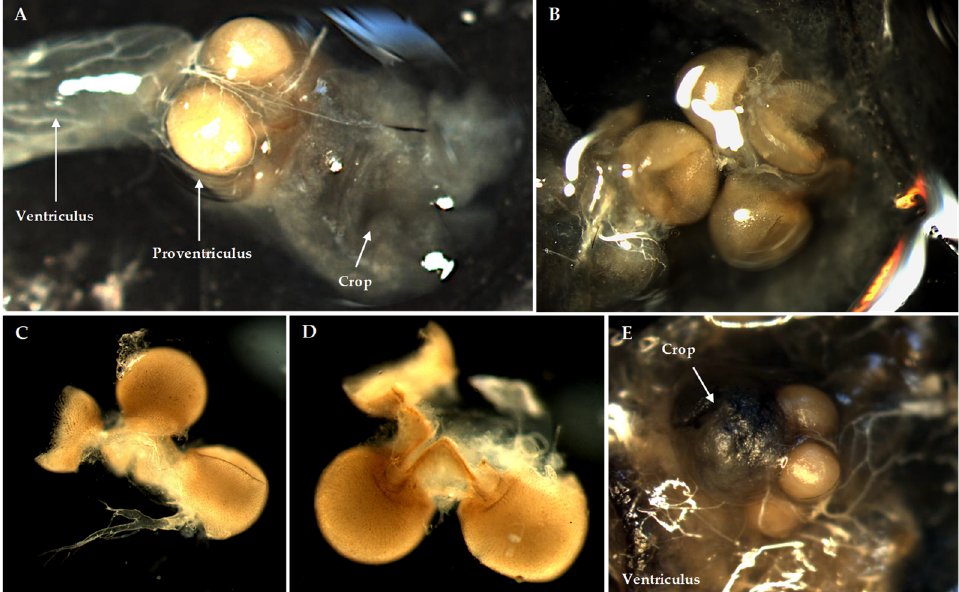
Figure 1. Abnormal male proventriculus. ( A ) Part of the alimentary tract of one B. terrestris male, showing the ventriculus, the abnormal proventriculus, and the crop or honey stomach. ( B – D ) Details of the abnormal proventriculus showing a high degree of melanization and abnormal growth; 400× ( E ) Crop containing plenty of rotten pollen, which was partially cemented and unable to pass through the proventriculus due to the deformation of its four lobes. Pictures recorded using Q IMAGING—Micropublisher (using IP Lab, Mac OS X, 10.3), and corrected using GIMP 2.10 (www.gimp.org, accessed on 13 September 2022). A normal alimentary tract of a bumble bee can be found in Zhang & Zheng [6].